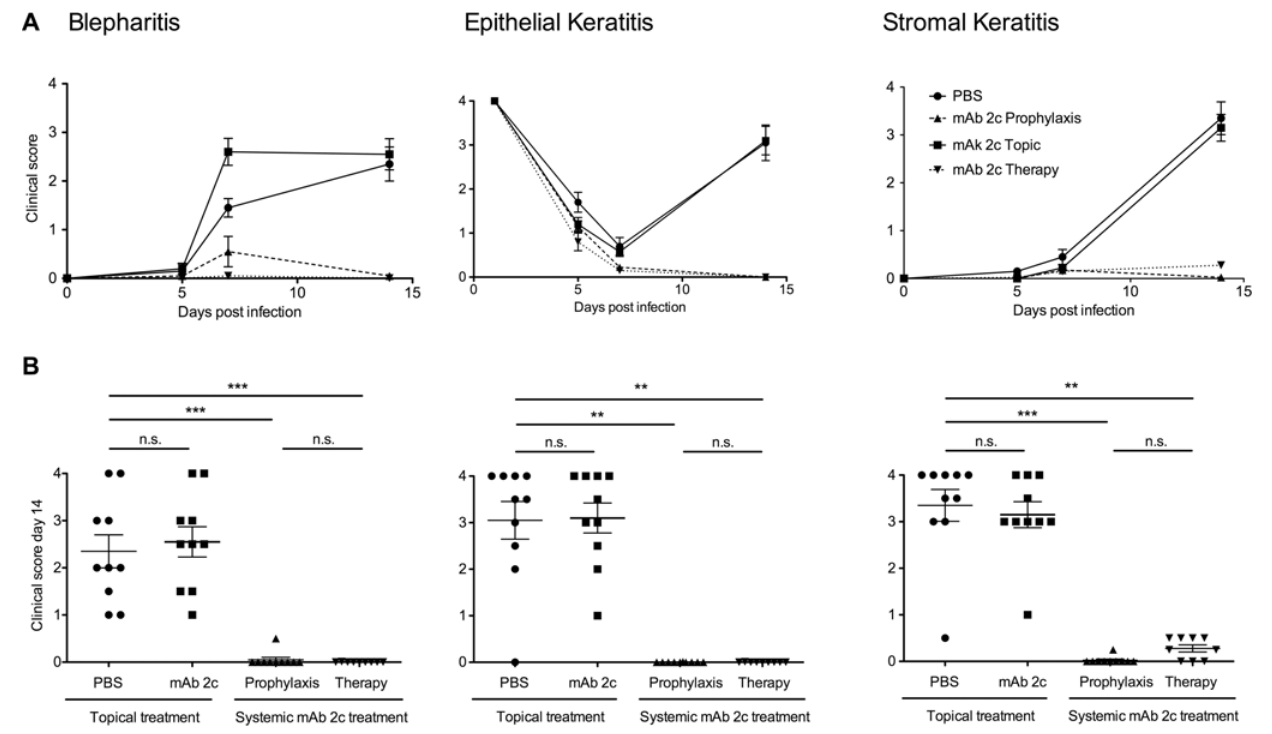
Figure 3. Effective prevention of corneal HSV-1 KOS infection in mice by systemic mAb 2c administration. Ocular disease scores of infected mice for blepharitis, epithelial defects and corneal opacity (stromal keratitis) are shown as an average score of ten mice per group over a period of 14 days (A) . The clinical disease scores taken on day 14 after infection are shown as dot plot (B) . Every dot represents a single mouse. Differences between the groups were statistically significant by a nonparametric ANOVA one way test ( ** P < 0.01; *** P < 0.001). Error bars represent the